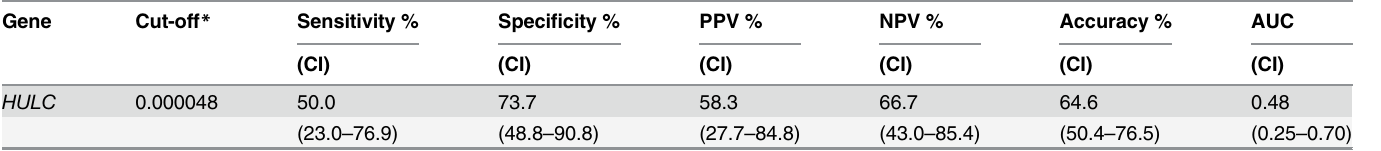
Table 2. HULC expression cut-off based on predictive probability of clinical outcome among the OS patients. Gene